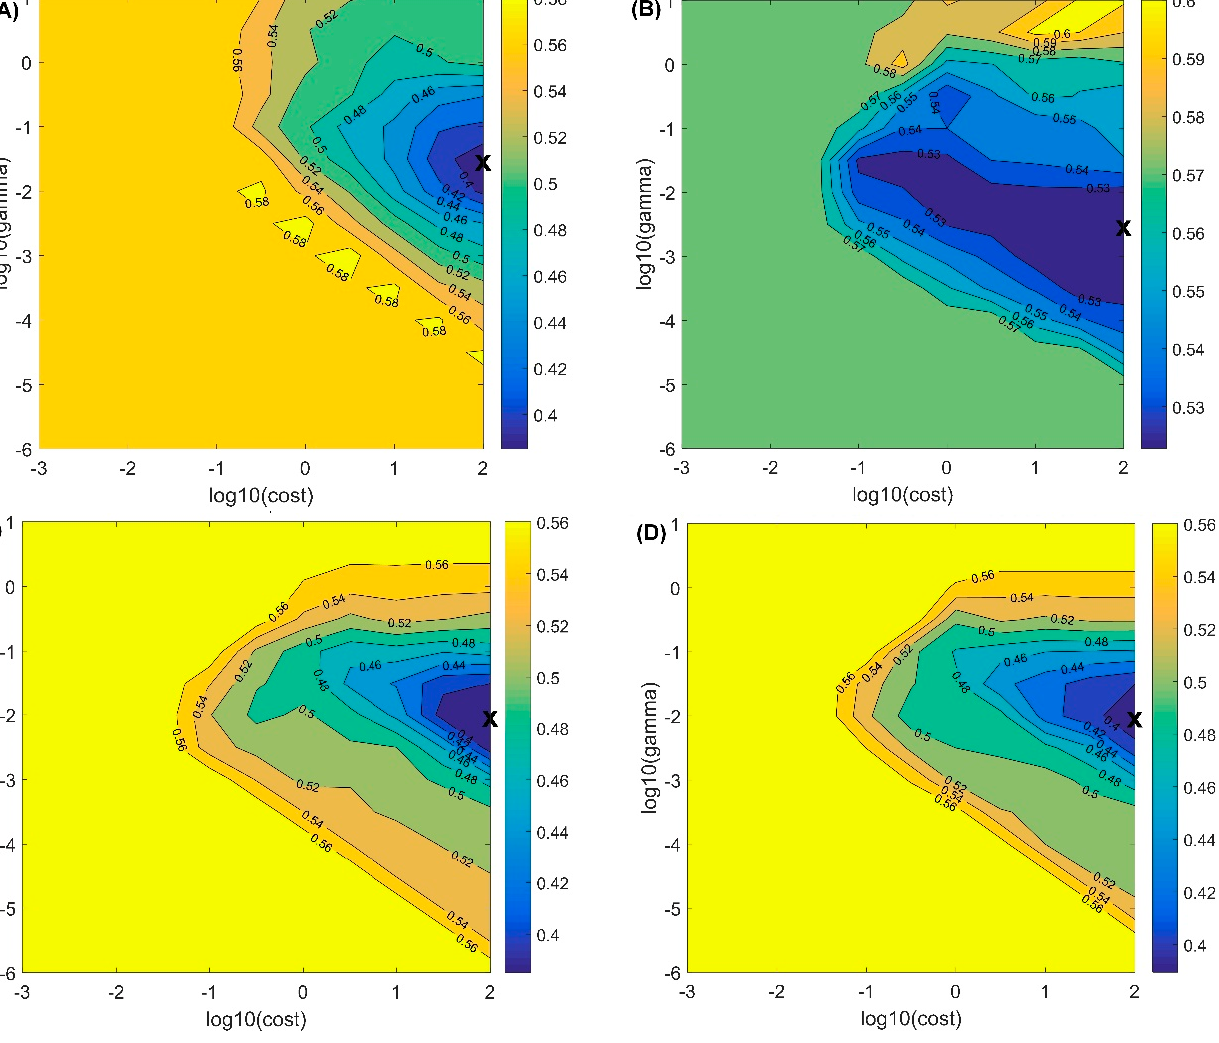
Figure 5. The misclassification fraction of cross-validation for the SVM model based on μ a ( A ), μ s ’ ( B ), μ a × μ s ’ ( C ), and μ eff ( D ).